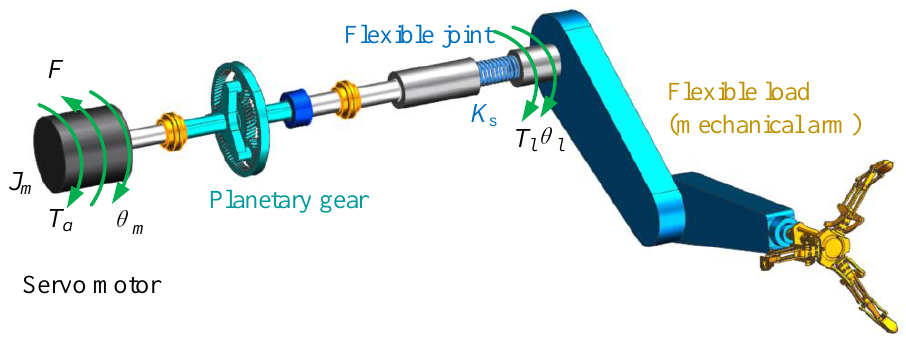
Figure 1. Schematic diagram of flexible joint with gears.